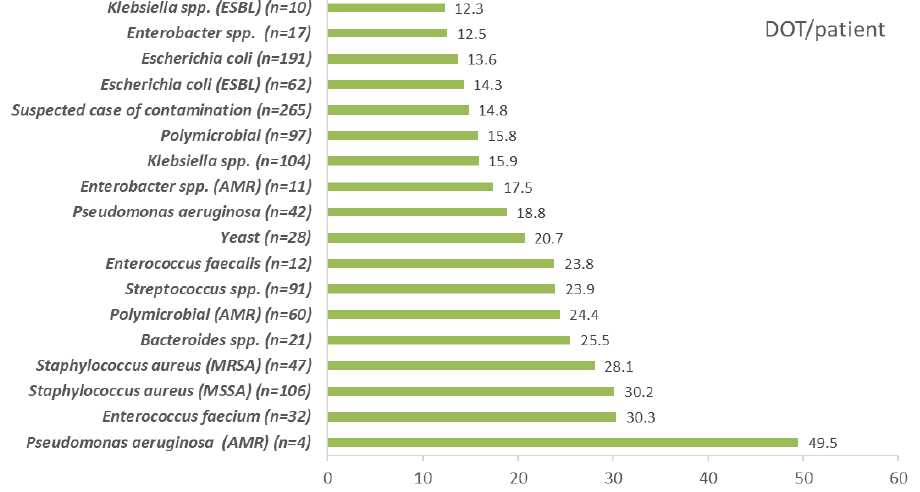
Figure 6. The DOT/patient distribution stratified by BSI pathogens. DOT, days of therapy; BSI, bloodstream infection; MSSA, methicillin-susceptible Staphylococcus aureus ; MRSA, methicillin-resistant Staphylococcus aureus ; ESBL, extended-spectrum beta-lactamase; AMR, antimicrobial resistance.